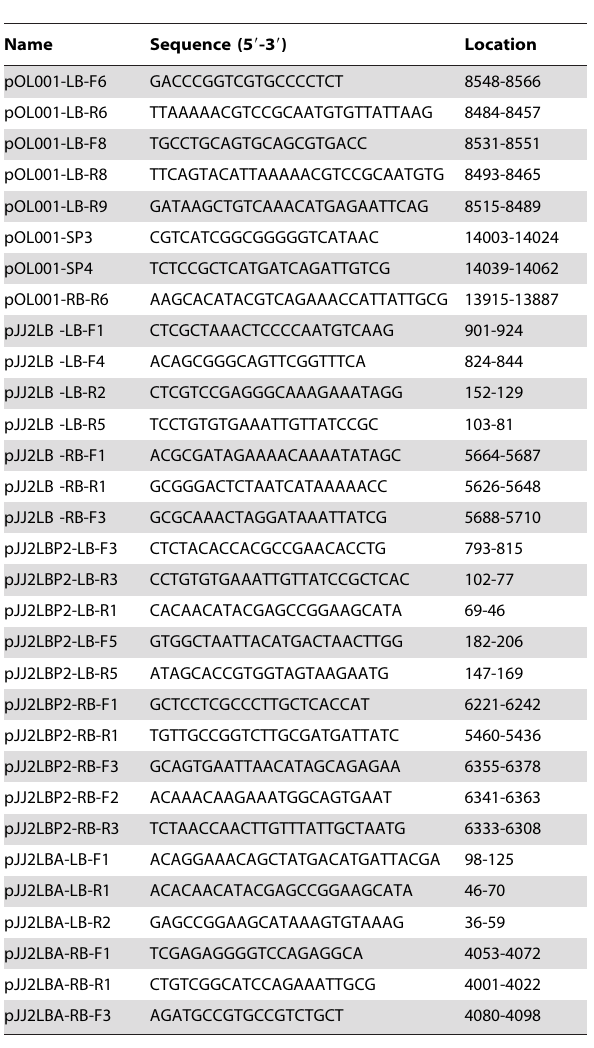
Table 3. T-DNA constructs evaluated for transformation